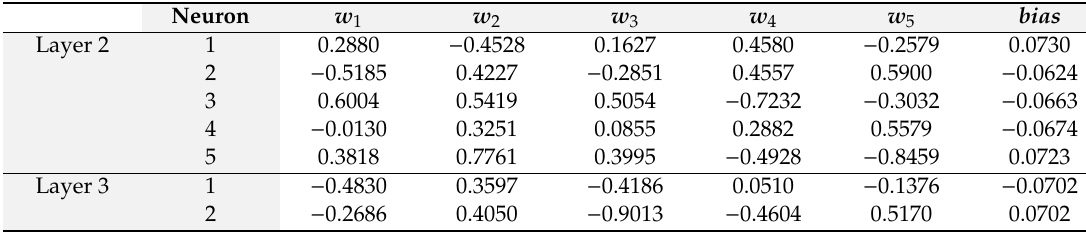
Table 5. Trained neural